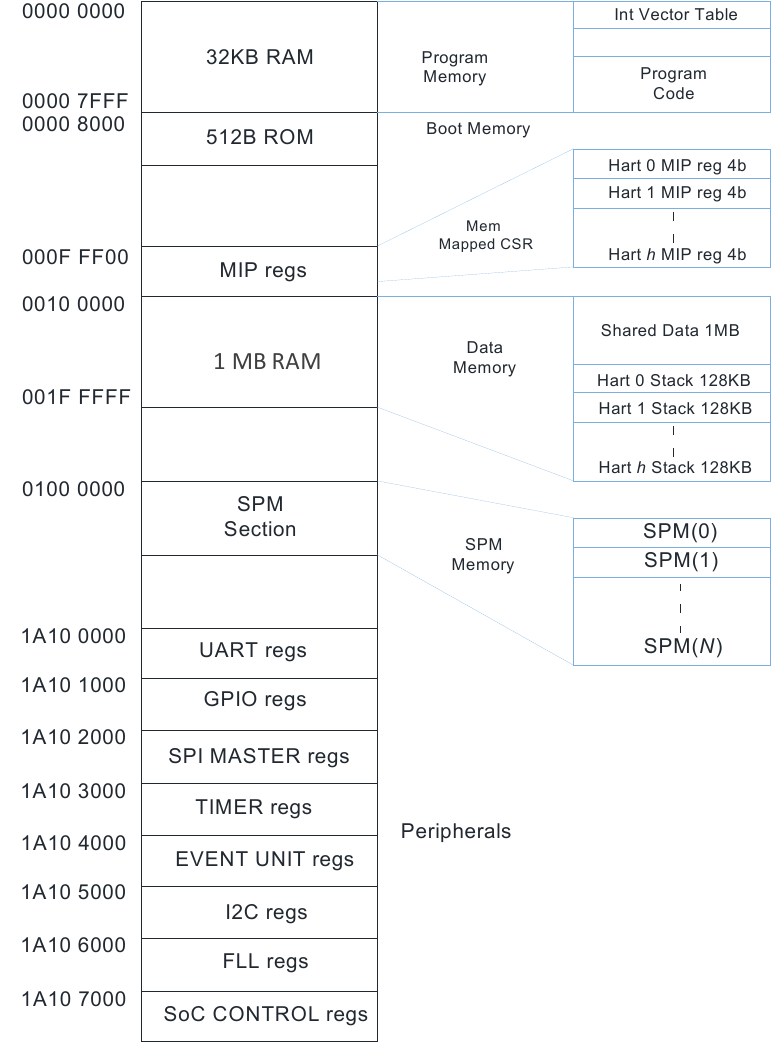
Figure 5. Klessydra T1 memory map.